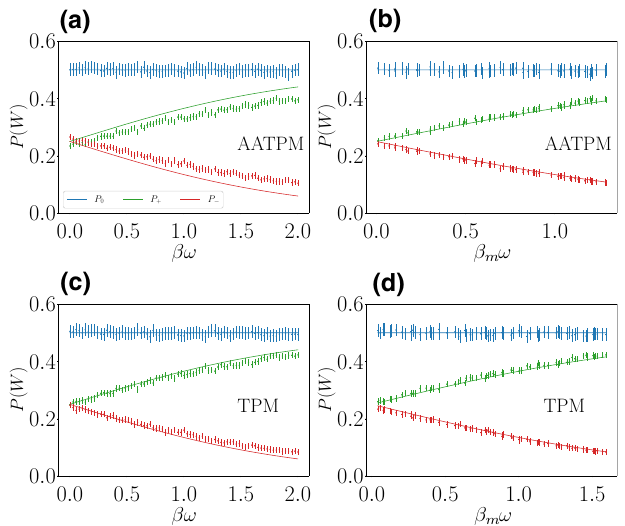
FIG. 2. (a),(c) Work statistics as a function of nominal rescaled inverse temperature for the standard TPM scheme and the AATPM scheme, respectively, for a qubit driven by a Hadamard gate. (b),(d) Same as (a),(c) but as a function of measured rescaled inverse temperature. Dots, experimental data; solid lines,